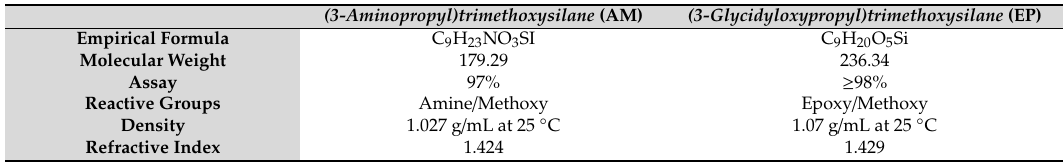
Table 2. Details of the silane coupling agents.